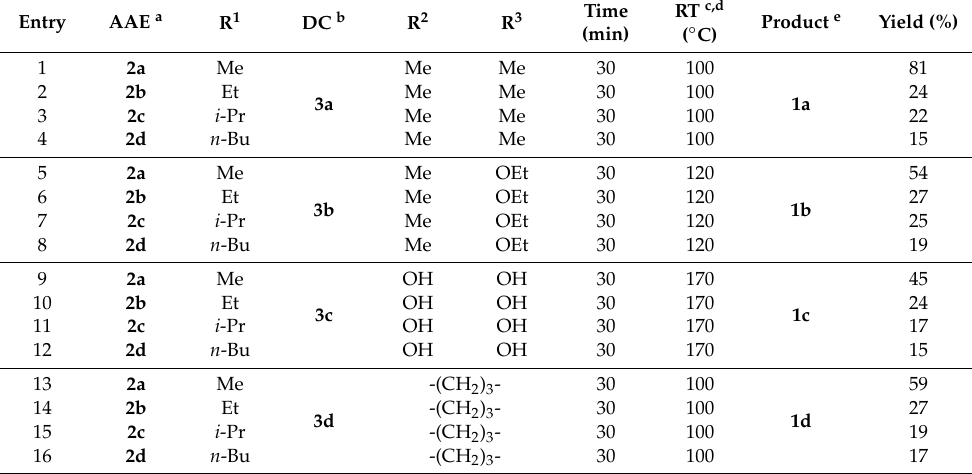
Table 1. Yields for obtained product ( 1 ) afforded via Scheme 1, employing solvent-free optimized conditions (time and temperature reaction) under conventional heating, considering different reaction mixtures stated as each entry.